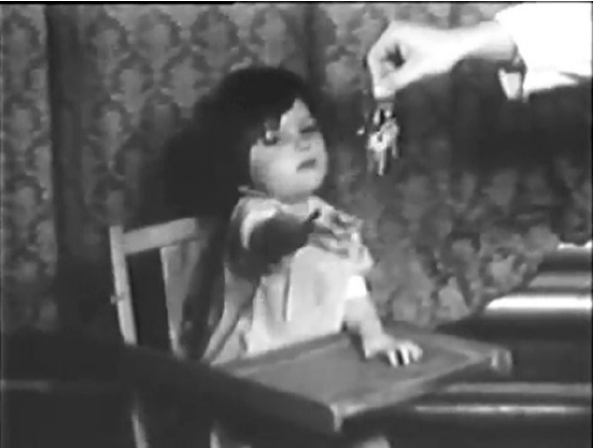
Figure 6. Sheila reaching for Dr. Bickel’s keys, 1952 in Birmingham (photograph reproduced with kind permission of the Jones family).